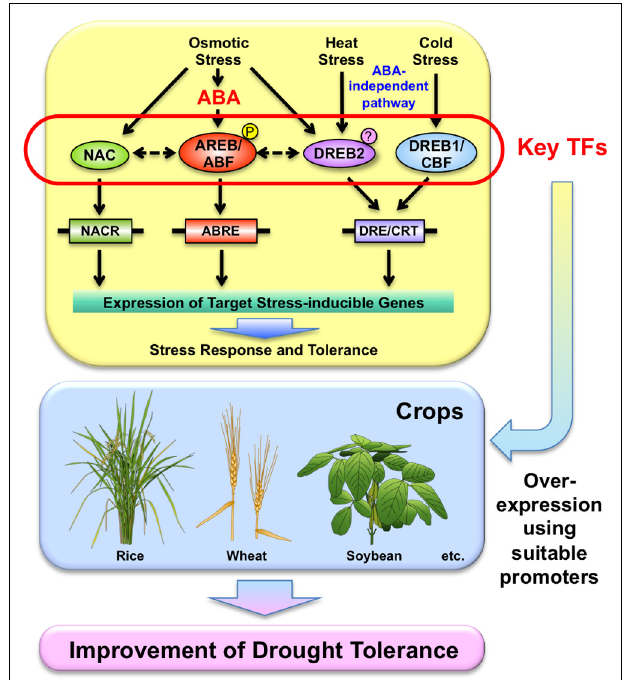
FIGURE 1 | Utilization of transcription factors (TFs) involved in stress-responsive pathways in stress responses for the improvement of drought tolerance of crops. Usage of suitable promoters might be necessary to control their